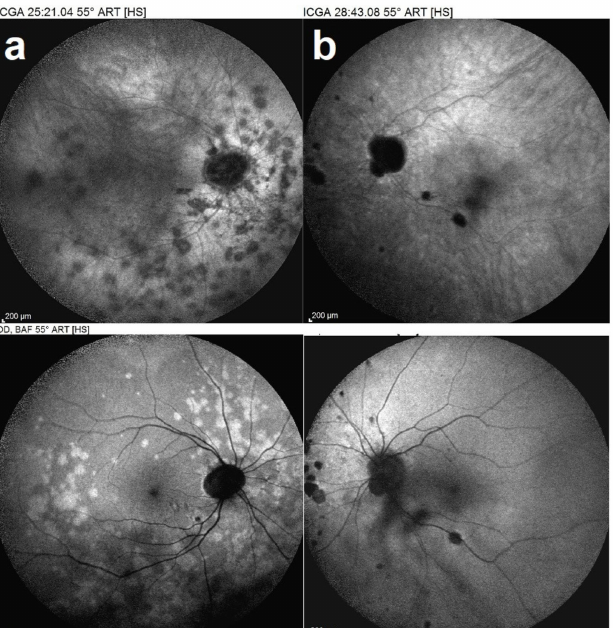
Figure 13. Idiopathic multifocal choroiditis, ICGA (top) and BL-FAF ( bottom ) findings. First episode of the right eye ( a ) in a period when left eye ( b ) showed no activity. ICGA OD (a top ) showed charac- teristic hypofluorescent dots corresponding to the hyperautofluorescent dots in BL-FAF (a bottom ), sign of activity.